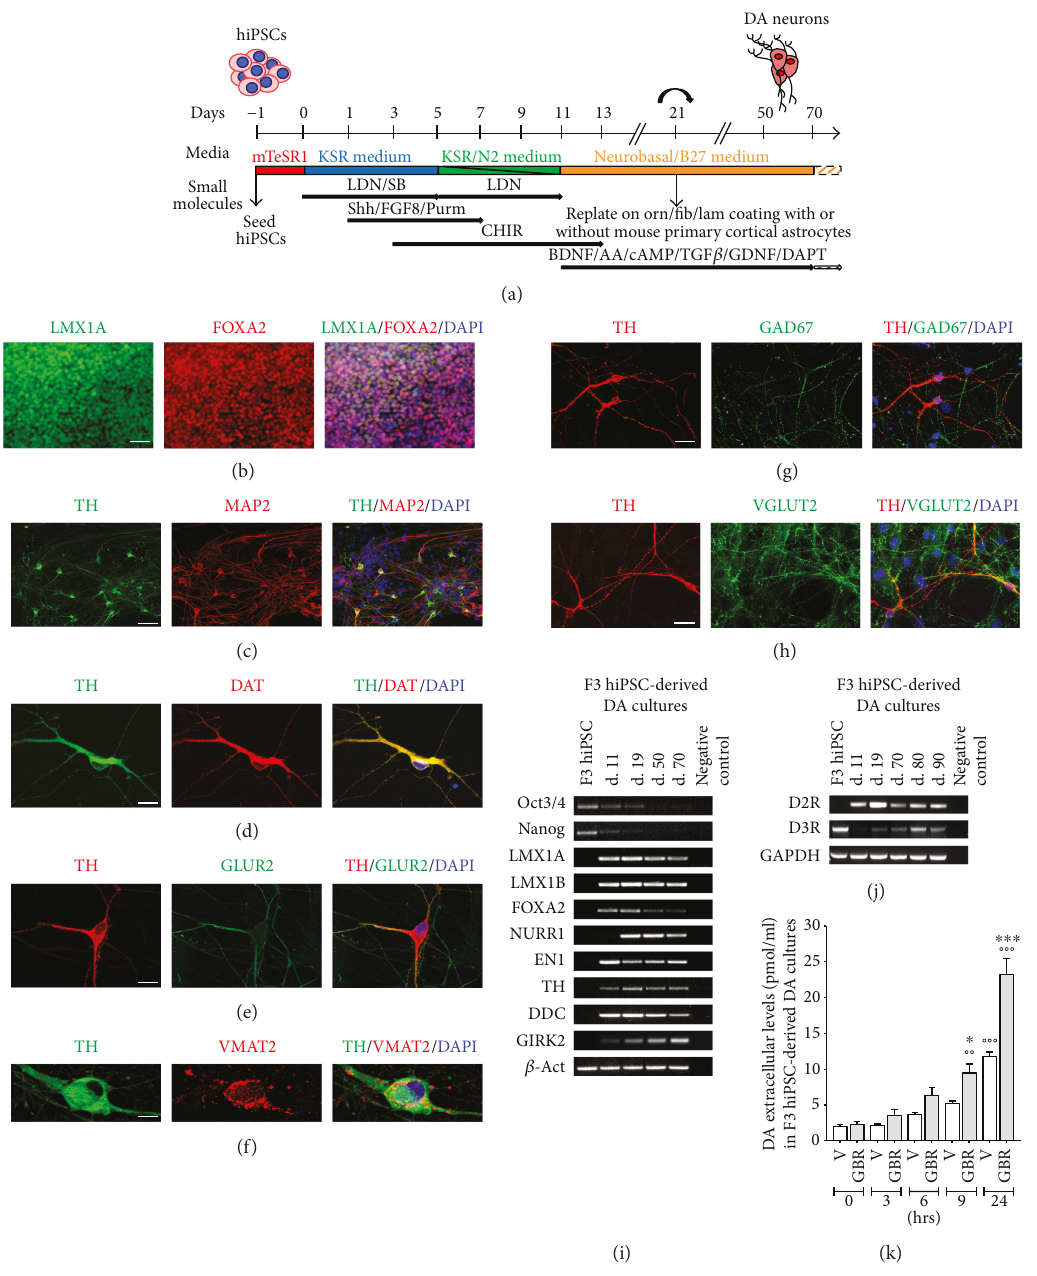
Figure 1: Di ff erentiation of F3 human iPSCs in dopaminergic neurons. (a) Diagram of the time and conditions used for the di ff erentiation of dopaminergic neurons from hiPSCs. (b – f) Representative images of dual immuno fl uorescence indicating coexpression of (b) LMX1-A (green) and FOXA2 (red) in dopaminergic progenitors at day 11; (c) TH (green) and MAP2 (red) in neurons at day 30; (d) TH (green) and DAT (red); (e) TH (red) and GLUR2 (green); and (f) TH (green) and VMAT2 (red) in DA neurons at day 70. (g, h) Dual immuno fl uorescence of (g) TH (red) and GAD67 (green) and (h) TH (red) and VGLUT2 (green) in neuronal cultures at day 70. Cell nuclei were stained with DAPI (blue). Scale bar: (b, c) =40 μ m; (d, e, g, and h)=20 μ m; and (f) =10 μ m. (i, j) Semiquantitative RT-PCR analysis of (i) gene expression at the iPSC stage and at day 11, 19, 50, and 70 of dopaminergic di ff erentiation and (j) expression of D2 and D3 receptors at the iPSC stage and at day 11, 19, 70, 80, and 90 of dopaminergic di ff erentiation (negative controls contain PCR Master Mix and primers, but no cDNA). (k) Dopamine level measured by HPLC in the supernatant of F3 DA cultures (day 70) following incubation with the DAT inhibitor GBR12935 (GBR) or vehicle (V) over a time course (0, 3, 6, 9, and 24hrs after administration). Data are expressed as mean ± SEM ( ∗∗∗ p < 0 001 versus vehicle at 24 hrs, ∗ p < 0 05 versus vehicle at 9hrs, and °°° p < 0 001 and °° p < 0 01 versus the corresponding treatment (GBR or V) at time 0h; post hoc Bonferroni ’ s test). KSR, knockout serum replacement; LDN, LDN193189; SB, SB431542; Shh, Shh C25II; FGF8, fi broblast growth factor 8; Purm, purmorphamine; CHIR, CHIR99021; BDNF, brain-derived neurotrophic factor; AA, ascorbic acid; cAMP, dibutyryl cAMP; TGF β , transforming growth factor type β 3; GDNF, glial cell line-derived neurotrophic